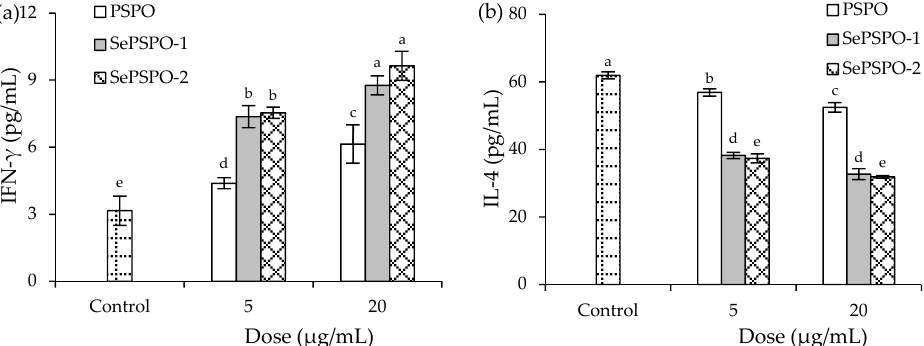
Figure 3. The detected levels of IFN- γ ( a ) and IL-4 ( b ) in the murine splenocytes incubated with PSPO, SePSPO-1, and SePSPO-2 for 48 h. Different letters lowercase above the columns suggest that the one-way ANOVA of the mean values is significantly different ( p < 0.05).